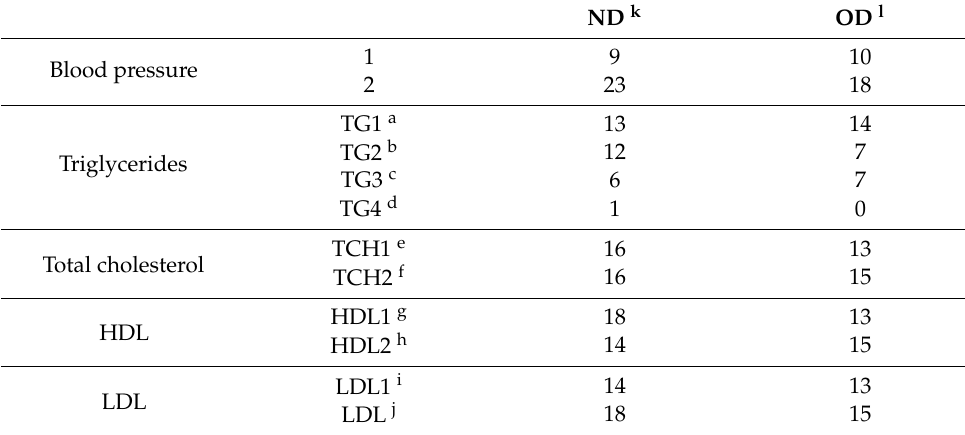
Table 2. Clinical characteristics of the sample at